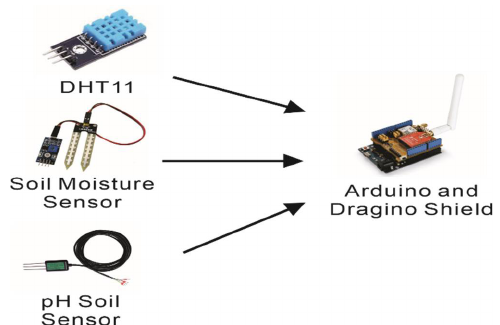
Figure 2. Client architecture.